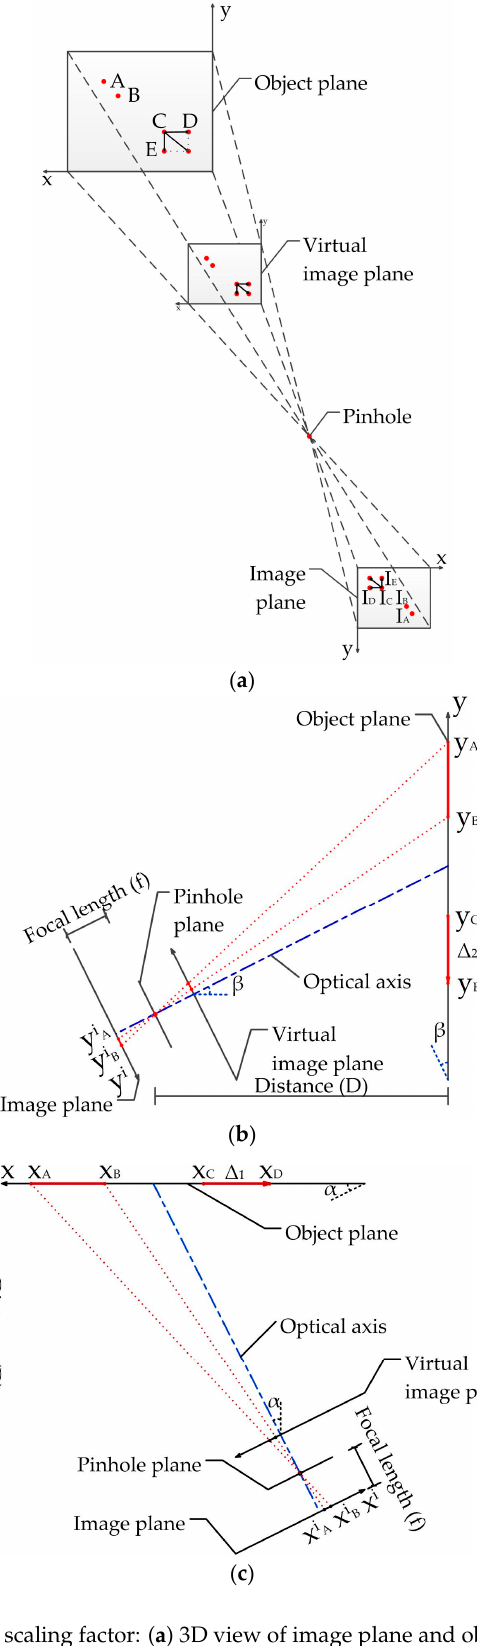
Figure 6. Error analysis of scaling factor: ( a ) 3D view of image plane and object plane; ( b ) optical axis non-perpendicular to object plane in the vertical direction; ( c ) horizontal direction.